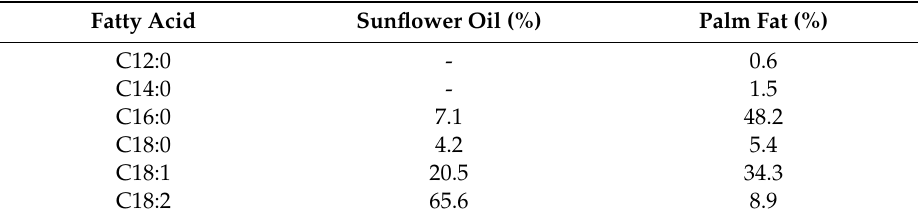
Table 1. Fatty acid composition of sunflower oil and palm fat. Fatty Acid Sunflower Oil (%) Palm Fat